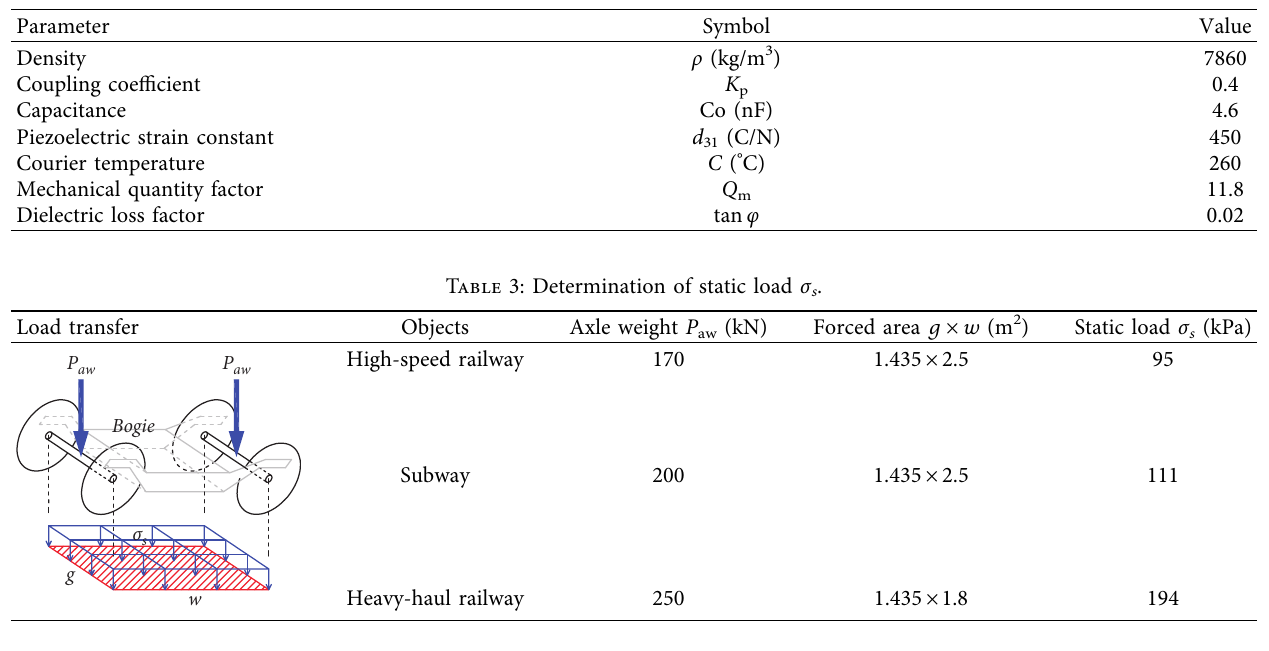
Table 4: Determination of dynamic loading σ